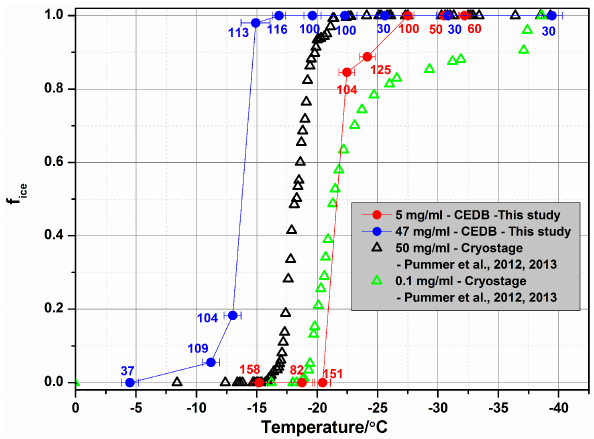
Figure 7. The temperature-dependent freezing fraction ( f ice ,) of 5 (red point and line) and 47mgmL − 1 (blue point and line) birch PWW droplets. Data from this study ( Betula fontinalis occidentalis , CEDB) is compared to the data reported in Augustin et al. (2013) for Betula pendula obtained using a cryostage microscope. The tem- perature error bar is calculated using both the stated probe accuracy from the manufacturer and the fluctuation of experimental temper- ature for each data point. The number in the figure is the droplet number for each data